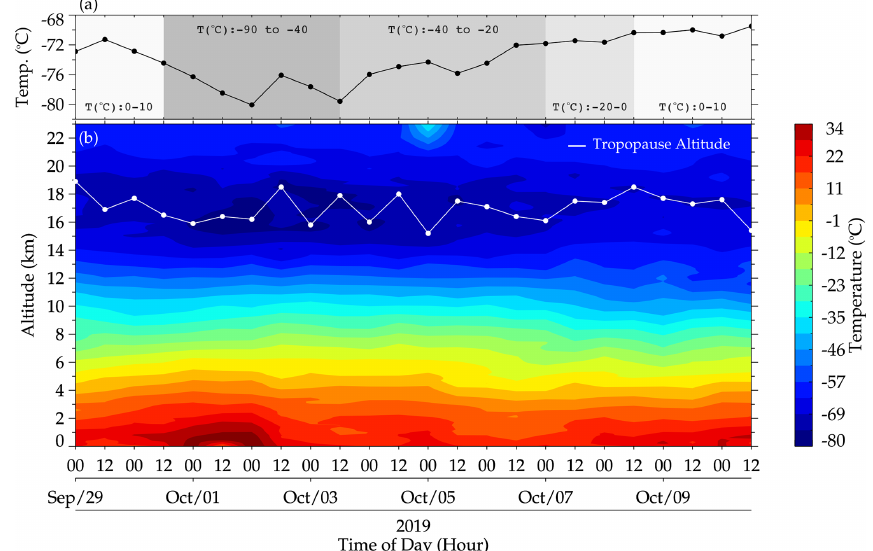
Figure 7. Tropopause temperatures and altitude variations at Santa Maria, RS, Brazil, from 29 September to 10 October 2019, obtained from radiosonde sounding measurements at 00:00 and 12:00UT. In panel (a) , the variation of the tropopause temperature (black line) through the days is presented. The grayscale regions with the label “ T ( ◦ C)” represent the temperature range of the cloud top. The contour plot in panel (b) shows the temperature profile from 0–23km through the days considered. The white line shows the variation of the tropopause altitude with their respective temperatures shown in (a) .